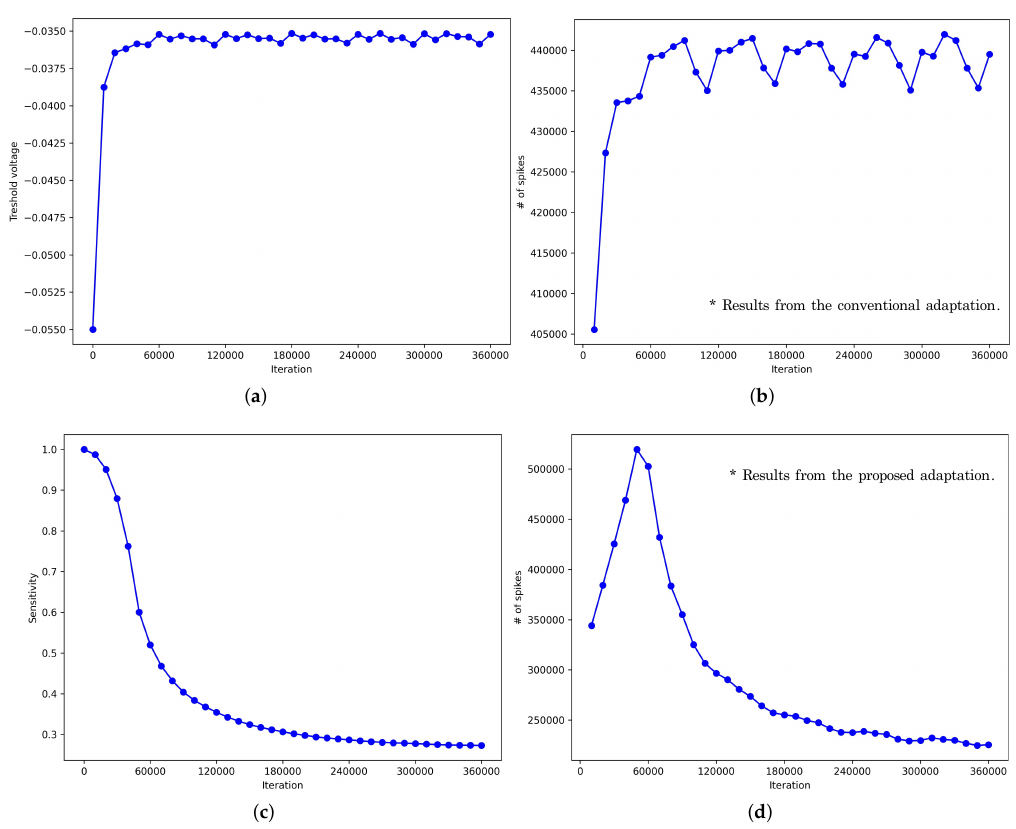
Figure 4. Trainingsimulation results: When using the V th variation-based adaptation, ( a ) the change in V th and ( b ) total number of spikes fired according to NOI changes, and when using the pro- posed sensory adaptation, ( c ) the change in g t and ( d ) total number of spikes fired according to Sens NOI